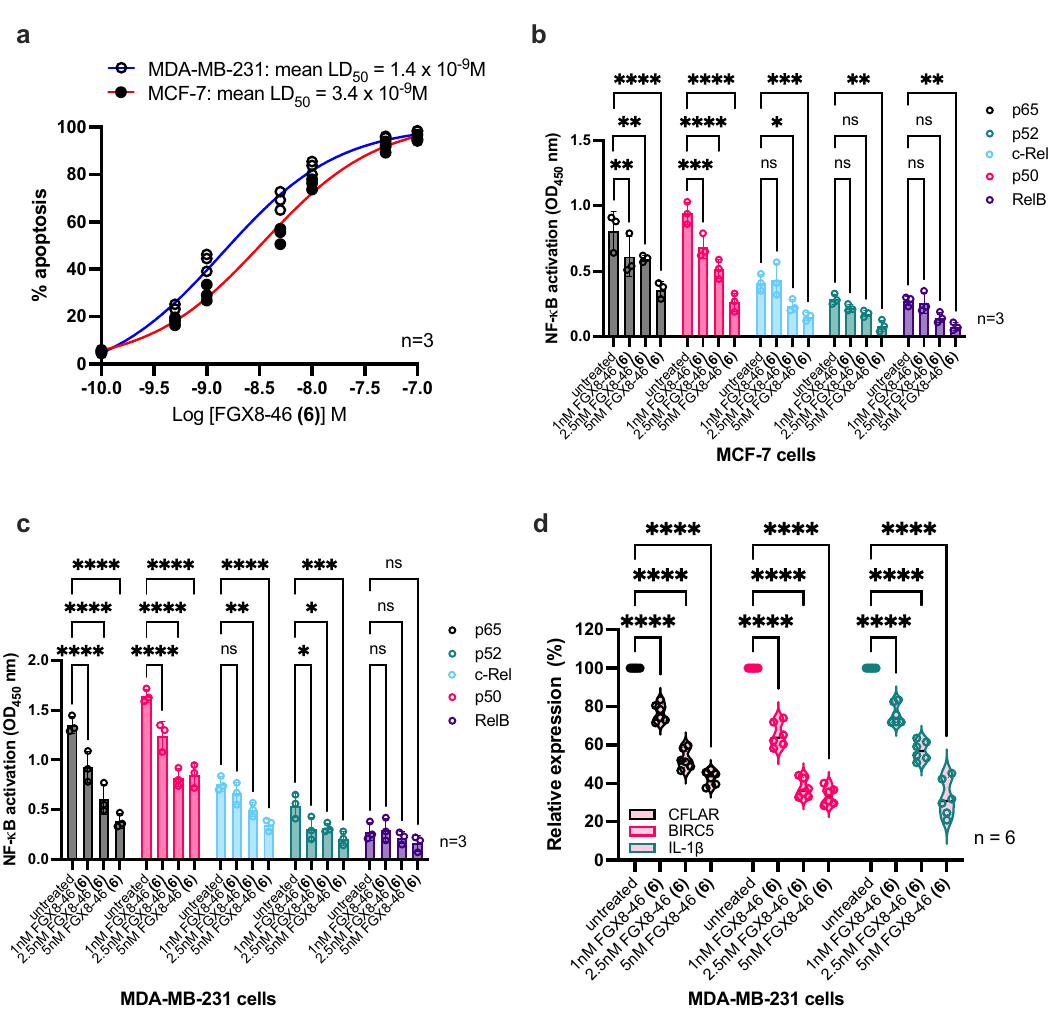
Fig. 6 Results of the NF- κ B transcription factor studies for the G-A DNA cross-linking agent FGX8-46 (6). a Determination of LD 50 values for FGX8-46 ( 6 ) in MCF-7 and MDA-MB-231 cell lines using Annexin V/7-AAD labelling methodology ( n = 3); b , c NF- κ B nuclear activity assays in MCF-7 and MDA- MB-231 cell lines, respectively, measuring the effect of 4 h exposure to 6 at concentrations of 1.0, 2.5 and 5.0 nM on P65, p52, c-Rel, p50 and RelB compared to untreated controls ( n = 3); d QRT-PCR validation assays on three NF- κ B target genes (CFLAR, BIRC5, IL-1 β ) in the MDA-MB-231 cell line. Each target transcript was quantitatively assessed using real-time RT-PCR, and the results were normalised to the amount of RPS14 transcript in all samples as an internal house-keeping control ( n =